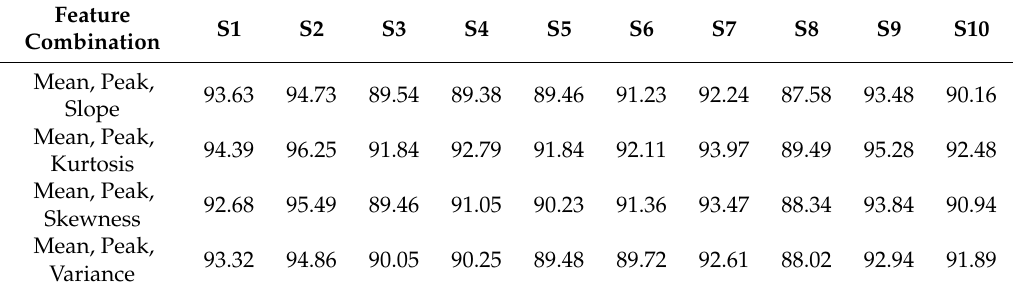
Table 3. The classification accuracies of the mean-peak feature combinations obtained from HbO signals for subjects.